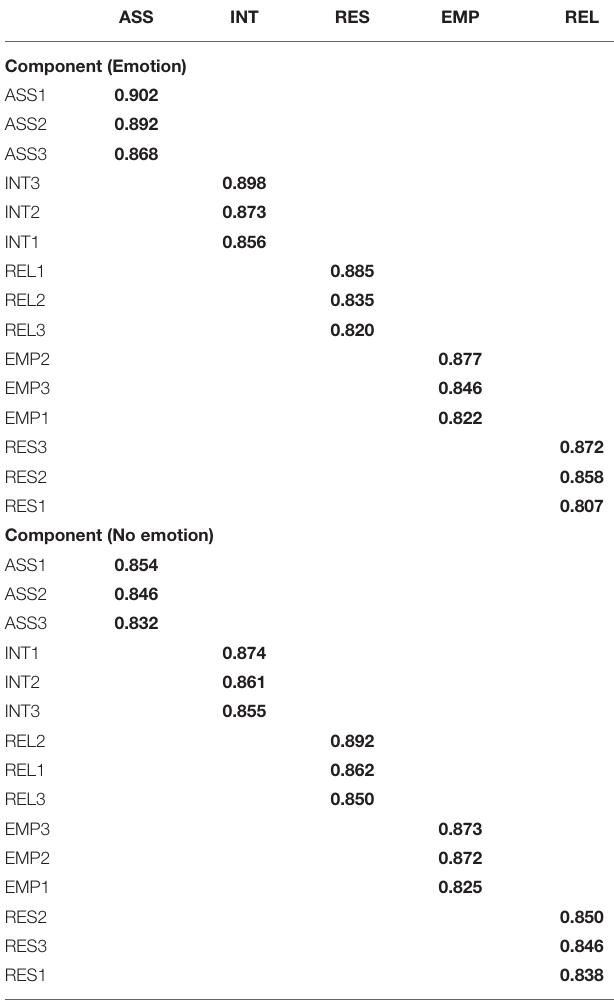
TABLE 2 | Results of exploratory factor